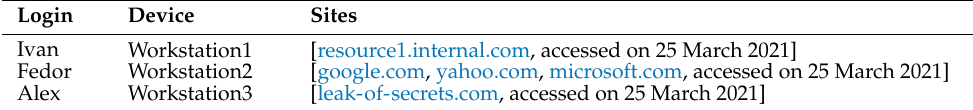
Table 12. Example of query results of the algorithm for Feature 7.